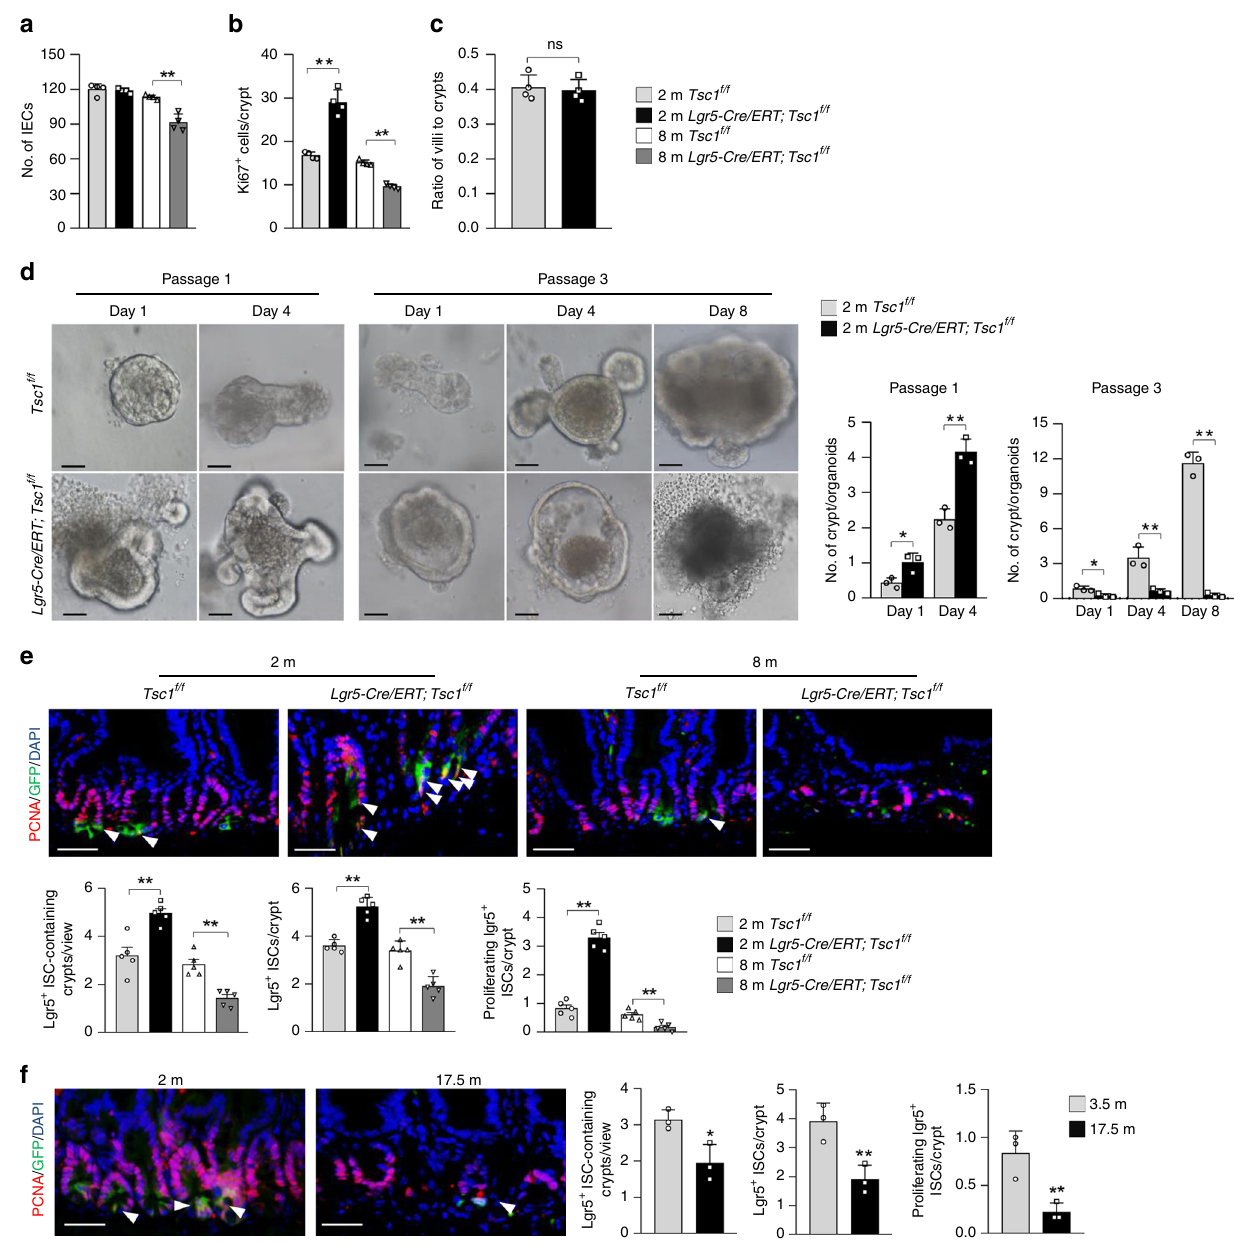
Fig. 3 Tsc1 deletion leads to defects in propagation of organoids and ISC/progenitor cells. a , b Eight-month-old Lgr5-GFP-CreERT;Tsc1 f/f mice showed decreases in the number of IECs ( a ) and the number of proliferating TA cells ( b ) (based on Fig. 2b). Data are expressed as mean ± SEM. N = 4 mice per group. ** P < 0.01 (determined using Student ’ s t test). c Eight-month-old Lgr5-GFP-CreERT;Tsc1 f/f mice showed no change in the villus-to-crypt ratios. N = 4. d Representative images showing that Tsc1 − / − crypts (isolated from Villin-Cre;Tsc1 f/f mice, since Lgr5-GFP-CreERT can label ~65% of the crypts) displayed increases in the size of the minigut organoids and the number of crypts, whereas serial passaging of the organoids revealed that Tsc1 -de fi cient organoids quickly lost their ability to propagate. Right panels: quanti fi cation of the data (mean ± SEM). N = 3 mice per group. * P < 0.05, ** P < 0.01 (determined using Student ’ s t test). e Eight-month-old Lgr5-GFP-CreERT;Tsc1 f/f mice showed decreases in the numbers of ISCs and proliferating ISCs. Intestine sections were immunostained for PCNA, and cells positive for PCNA and GFP were counted and normalized to the total numbers of Lgr5 + ISCs. Bottom panels: quantitation data (mean ± SEM). N = 5 mice per group. ** P < 0.01 (determined using Student ’ s t test). f The numbers of ISCs and proliferating ISCs were decreased in naturally aged 17.5-month-old mice. Right panels: quantitation data (mean± SEM). N = 3 mice per group. * P < 0.05, ** P < 0.01 (determined using Student ’ s t decreased in 8-month-old Lgr5-CreERT;Tsc1 f/f mice (Fig. 3e). Similarly, the numbers of Lgr5 + ISCs and proliferating Lgr5 + ISCs were decreased in naturally aged mice (Fig. 3f). Overall, these results suggest that both Tsc1 de fi ciency-induced villus premature aging and natural aging are likely caused by decreases in the number of ISC/TA cells.